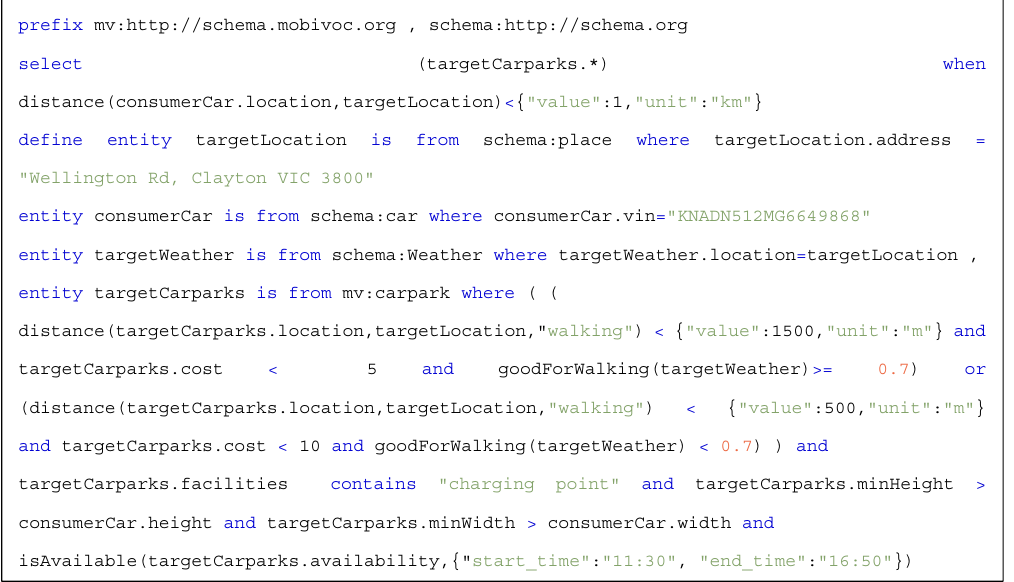
Figure 24. PoC parking application screenshot. ( a ) bad weather conditions; ( b ) good weather conditions.